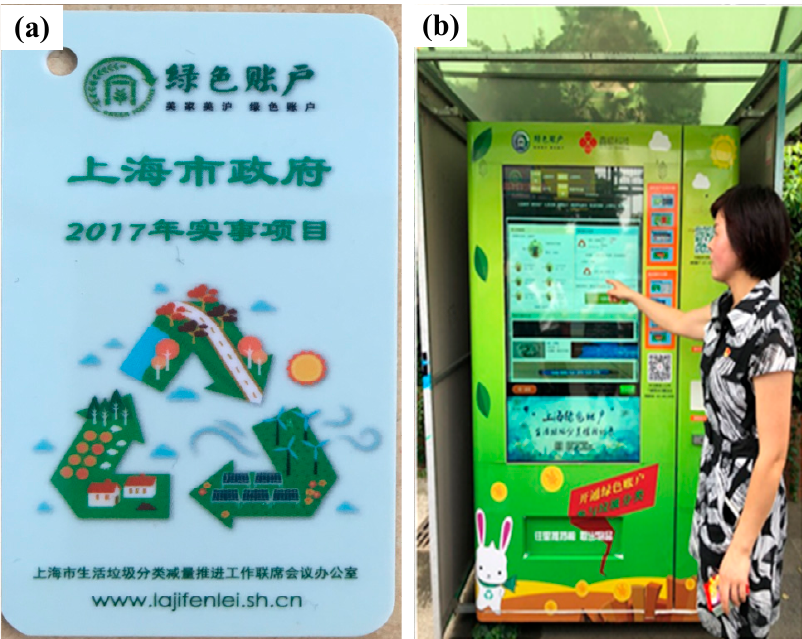
Figure 6. Pictures of Green Account. ( a ) Green Account card, ( b ) automated credit–goods exchange machine [30].